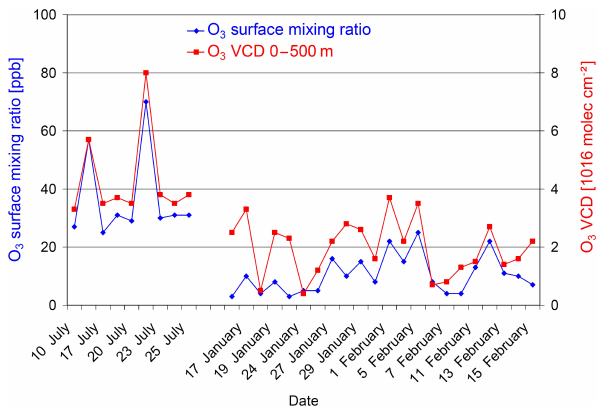
Figure A4. O 3 mixing ratios and tropospheric VCDs at the location of the highest NO 2 VCDs for all days.